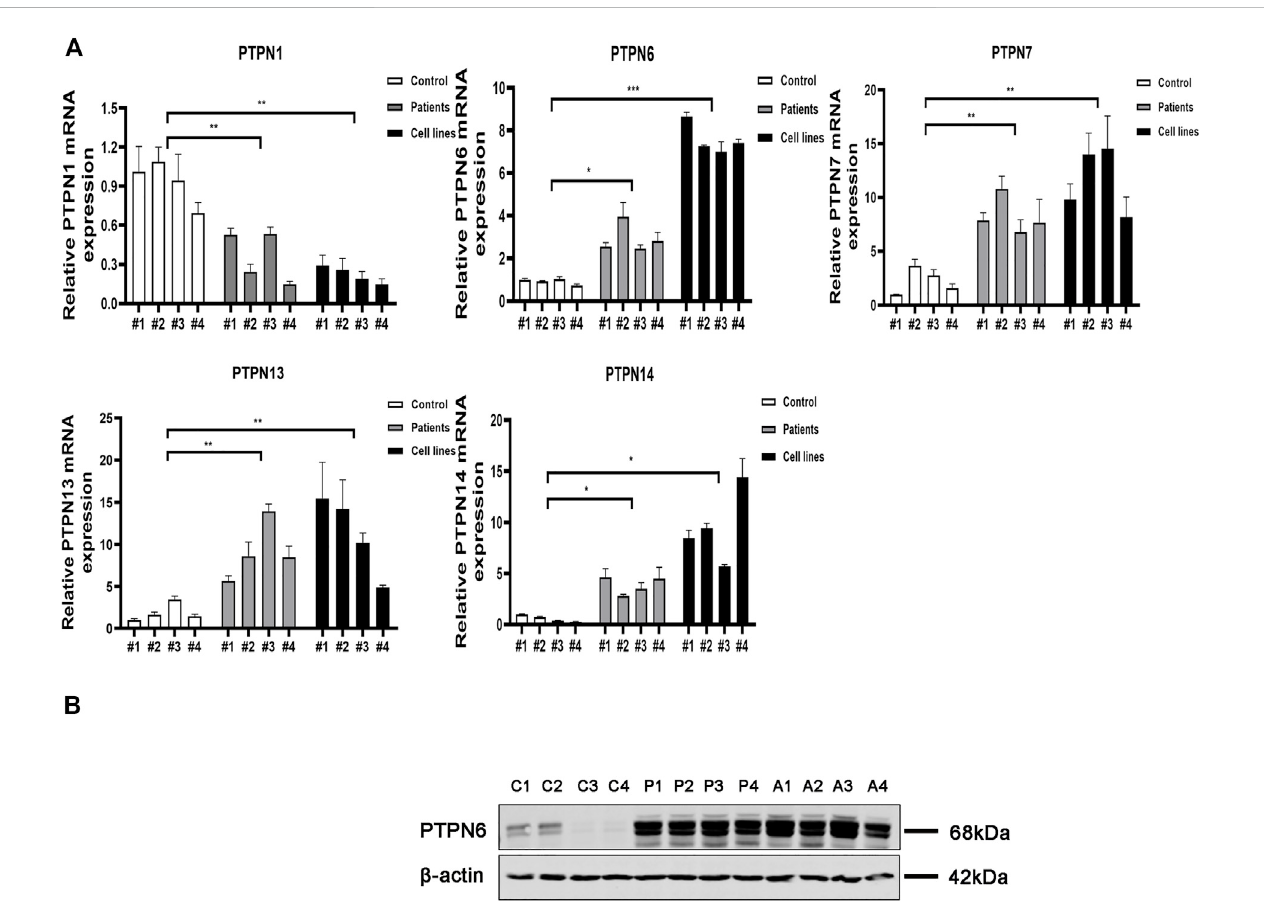
FIGURE 4 Relative mRNA and protein expression of the PTPN gene in AML samples and AML cell lines and normal controls were detected by qRT-PCR and westernblotting. (A) RelativemRNAexpressionofPTPN geneinAMLsamplesandAMLcell linesandnormal healthy controlsdetectedby qRT-PCR. (B) Protein expression levels of PTPN6 in AML samples and AML cell lines and normal healthy controls detected by western blotting. Note: C1-C4 represent 4 normal controls, P1-P4 control 4 AML clinical samples, A1-A4 represent 4 AML cell lines including HL-60, KG-1, THP-1, and